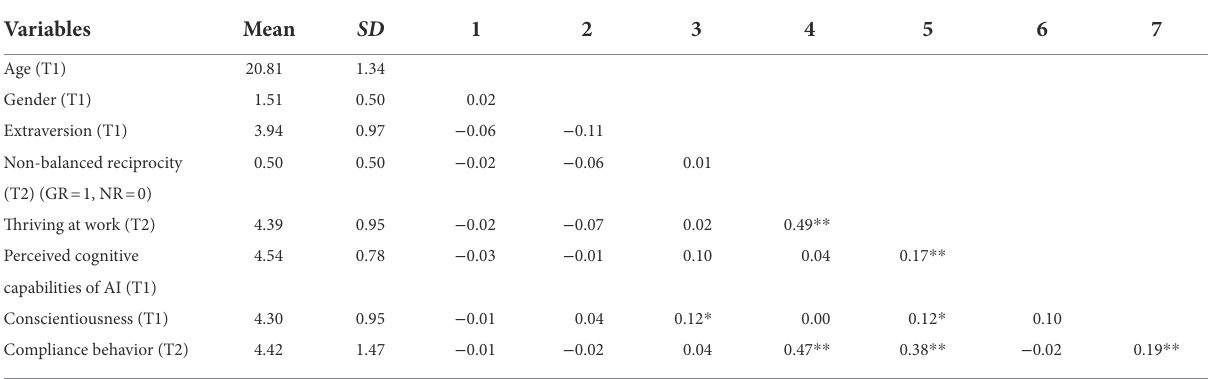
TABLE 2 Standard deviations, means, and correlations among the